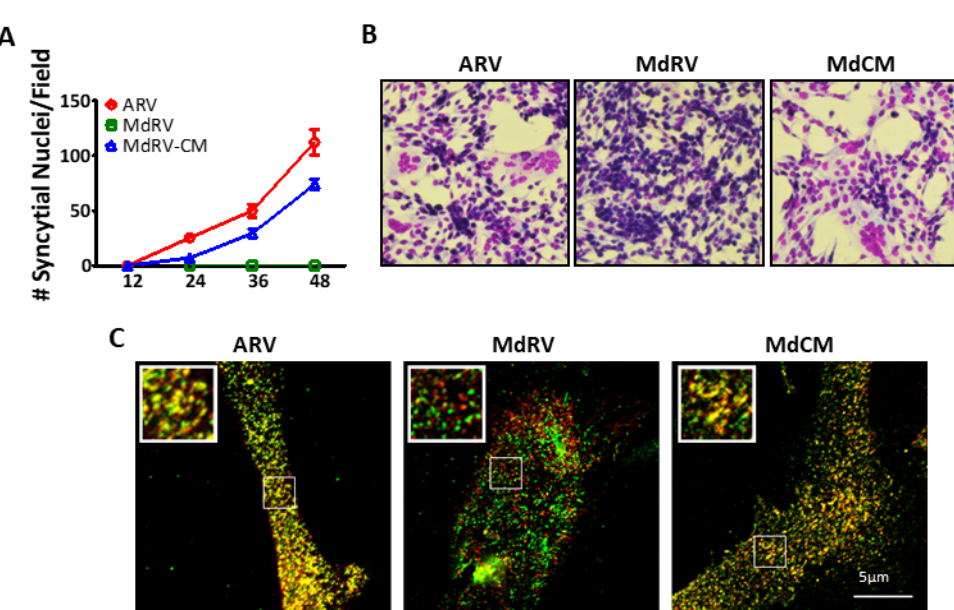
Figure 6. The ARV p10 CM restores fusion activity and clustering of MdRV p10 in plasma membrane microdomains. ( A ) Transfected QM5 cells with authentic ARV or MdRV p10 or expressing the